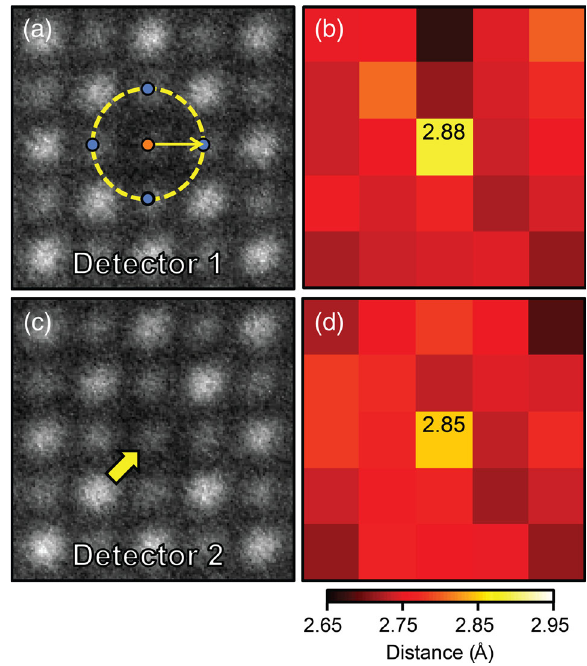
FIG. 3. Local structure relaxation around Sr vacancies. (a,c) Magnified HAADF STEM images near column-A recorded with detectors 1 and 2, respectively. (b,d) Atomic distance maps, where each pixel value indicates the average distance from one cation to its four nearest-neighbor unlike cations, showing Ti-O columns being displaced away from Sr vacancies. The overlay in (a) shows an example of a distance measurement from a Sr column (orange circle) to the Ti-O columns (blue